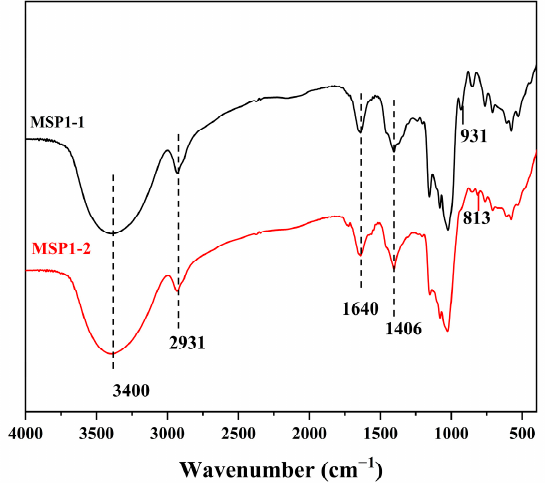
Figure 2. Fourier transform infrared (FT-IR) spectra of MSP1-1 and MSP1-2.